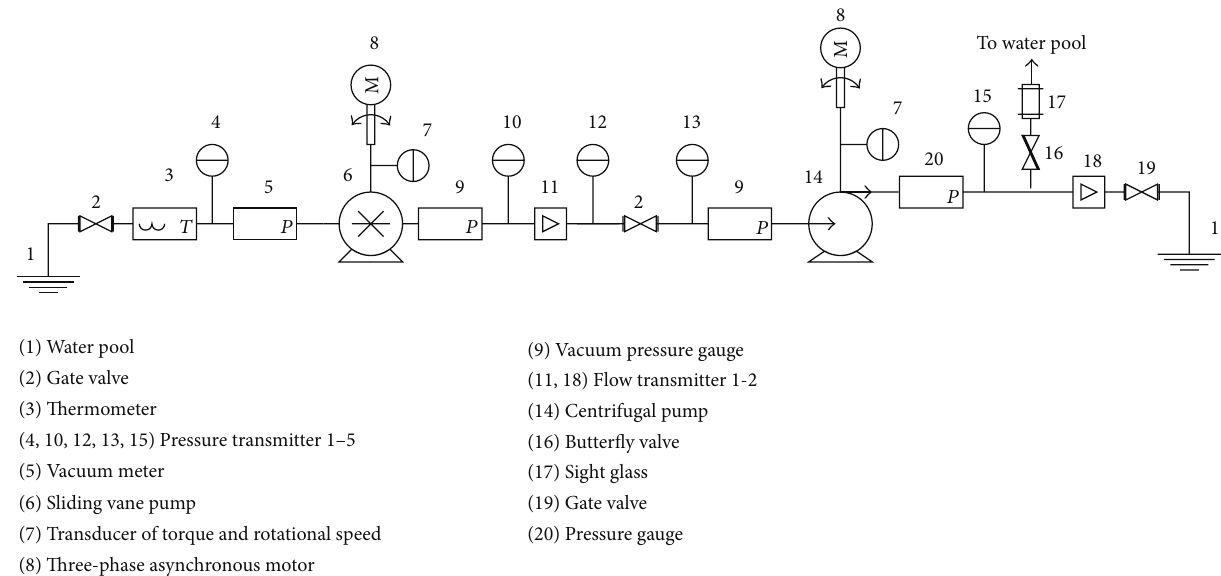
Figure 4: Series operation flowchart of sliding vane pump and centrifugal pump.